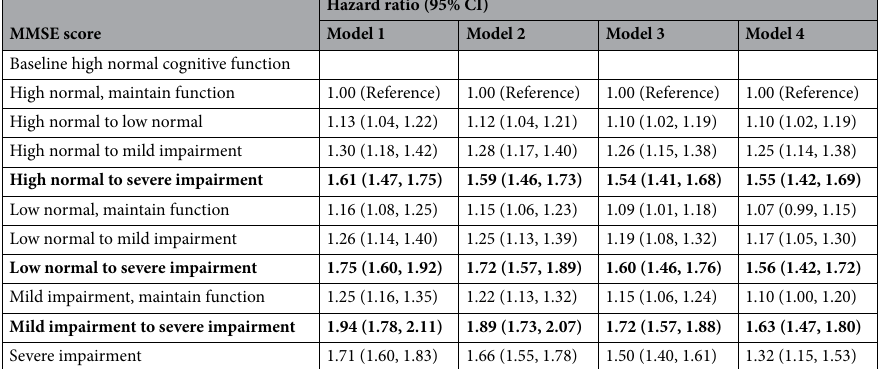
Table 1. Association of cognitive decline with mortality after adjustment for different covariates. Model 1: adjusted for demographic characteristics (sex and age); Model 2: adjusted for the covariates in model 1 plus socioeconomic status (residence, educational background, current spouse status, marital status and living pattern) and lifestyle factors (regular exercise, current smoking status, current drink status, dietary diversity (DD)); Model 3: adjusted for the covariates in model 2 plus leisure activities (housework, reading, watching TV and listening to the radio, keeping pets and growing flowers); Model 4: adjusted for the covariates in model 3 plus health conditions (high blood pressure (BP), disability in activities of daily living (ADL), and respiratory disease). Significant values are in